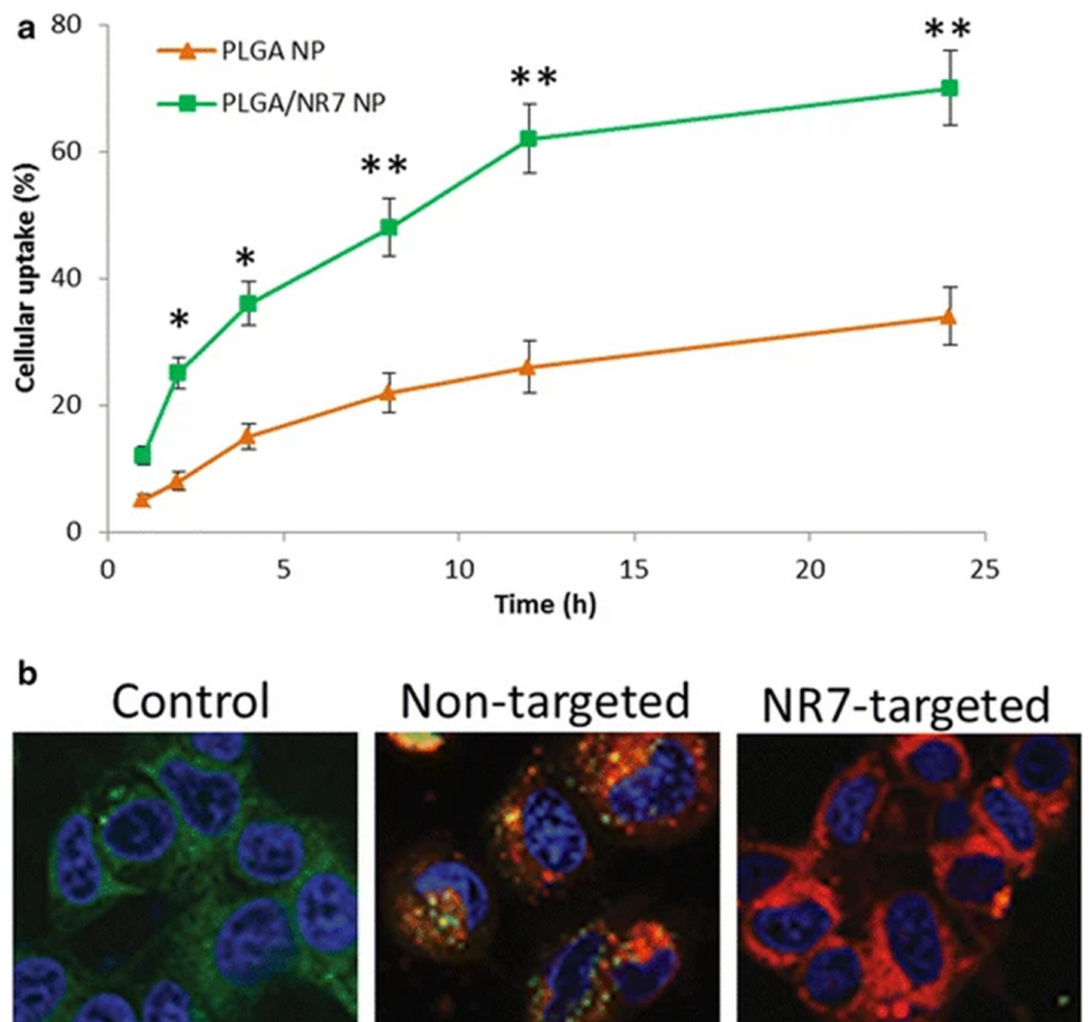
Figure 7. ( a ) Intracellular uptake of PLGA NP and PLGA/NR7 NPs in HN6 squamous cell carcinoma. Rhodamine B was used as a fluorescent dye. The uptake is shown as a percentage of total amounts of NPs (dye) incubated with the cancer cells. ( b ) Representative confocal microscopy images of targeted and non-targeted NP in HN6 cancer cells. The cells are stained with the Lysotracker lysosomal stain and DAPI was used to stain the nucleus. ** p < 0.01 and * p < 0.05 are the statistical differences between the cellular uptake of two formulations. Reproduced with permission from Wang et al.